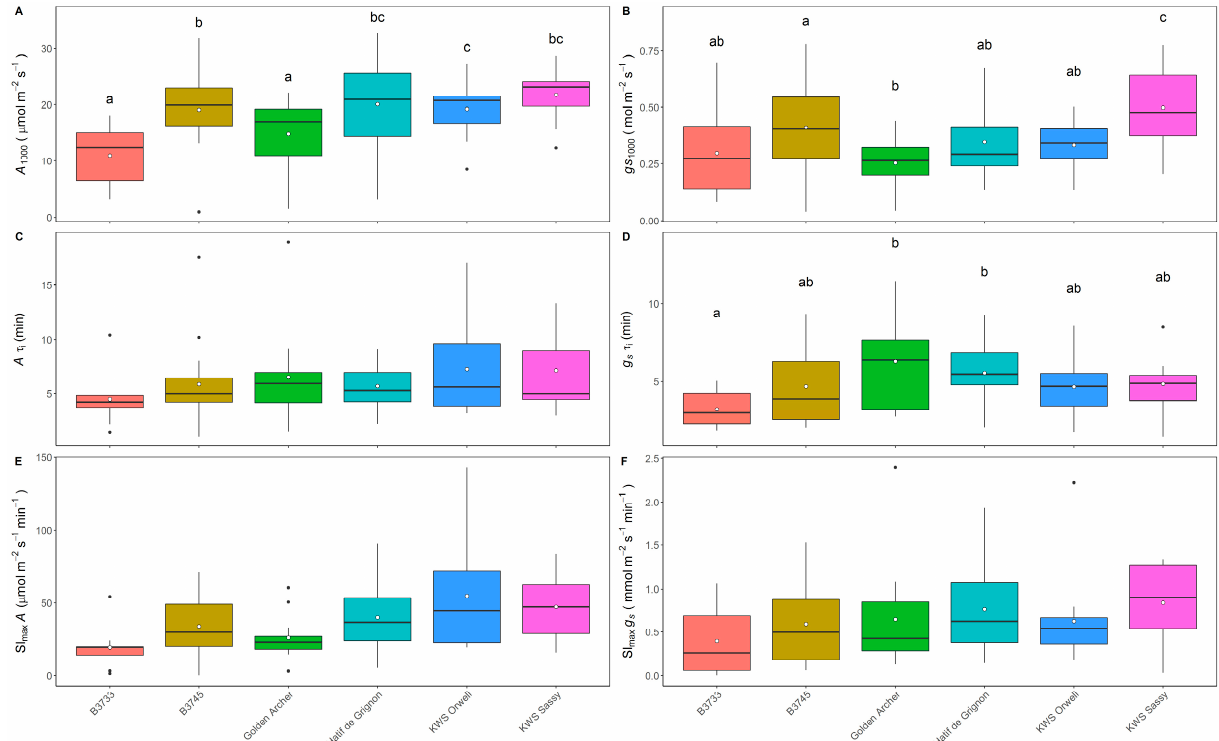
Figure 2. Kinetic parameters modelled according to the method in Vialet-Chabrand et al [48] from step changes light shown in Figure 1 for the wild barleys B3733 and B3745, the landraces Golden Archer and Hatif de Grignon, and the elite cultivars KWS Orwell and KWS Sassy. Left-hand side— assimilation parameters, right-hand side— stomatal conductance. ( A ) Maximal rate of A achieved at 1000 µ mol m − 2 s − 1 PPFD during the test. ( C ) Time constant for assimilation to increase by 63%. ( E ) Maximal rate of change of response of A to increasing light. ( B ) Maximal rate of g s achieved at 1000 µ mol m − 2 s − 1 PPFD during the test. ( D ) Time constant for stomatal conductance to increase by 63%. ( F ) Maximal rate of change of response of gs to increasing light. N = 5–6, box and whisker plots with means shown as white dots. Identical letters show no significant differences between means based on Tukey’s test of model outputs at p = 0.05.